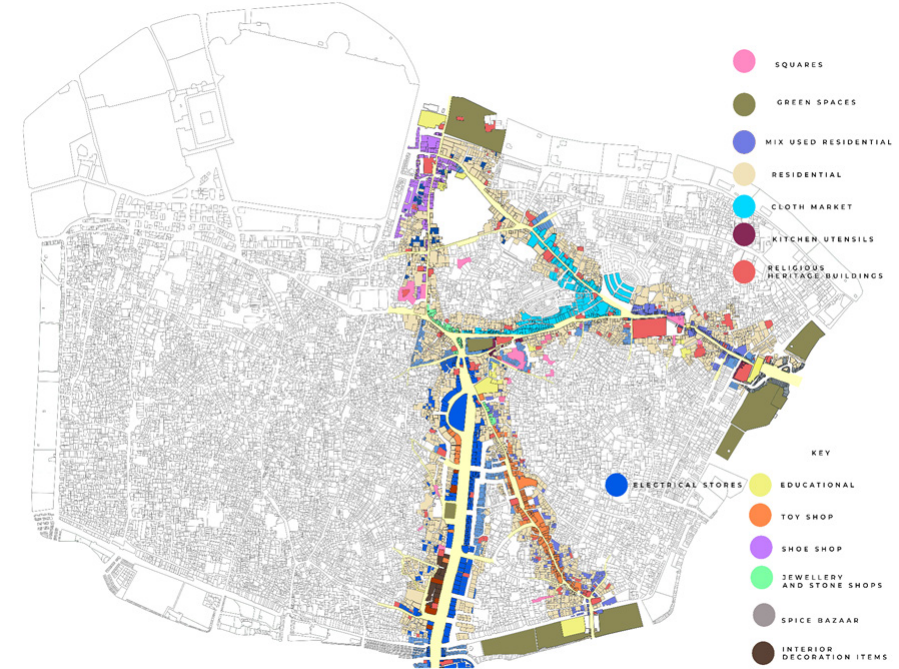
Figure 4 . Selected streets in Walled City of Lahore (developed by Zahid,